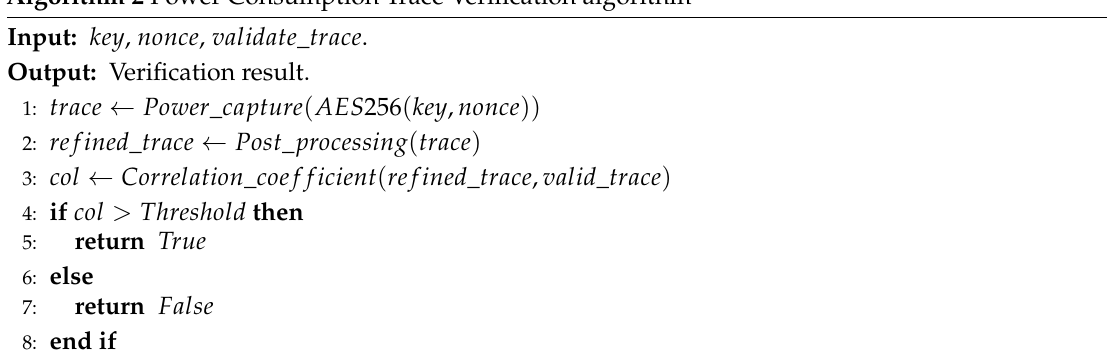
Figure 3. Comparison of correlation coefficient for power traces ( left ) without post-processing and ( right ) with post-processing. Algorithm 2 Power Consumption Trace Verification